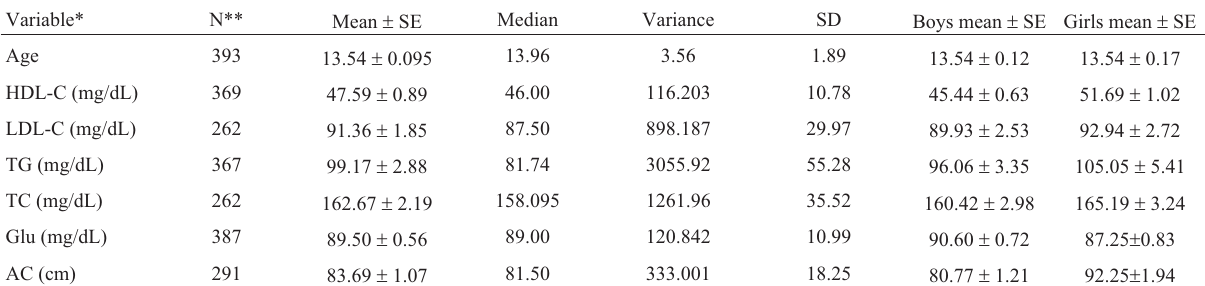
Table 1 - Descriptive statistics for age, lipid profile, glucose, and abdominal circumference of the 393 individuals analyzed in this study. Variable*